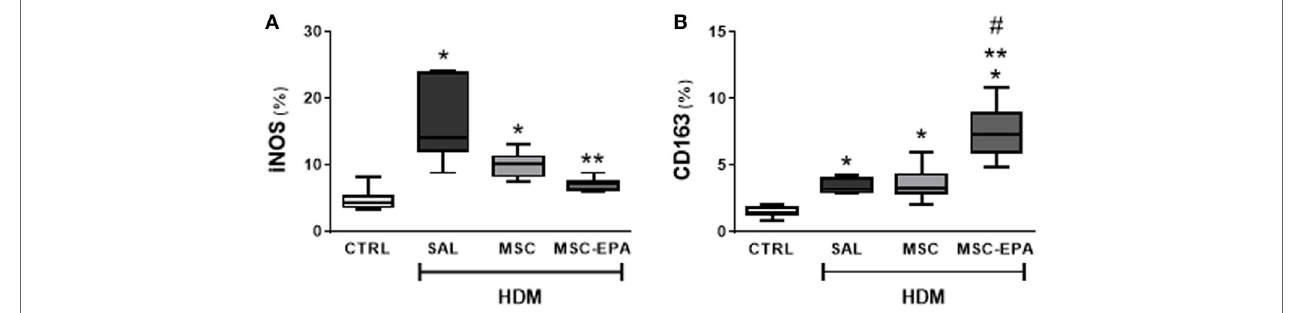
FigUre 3 | EPA-stimulated MSCs induced macrophage polarization toward an M2 rather than M1 profile. (a) M1-macrophage (iNOS + ) and (B) M2-macrophage (CD163 + ) counts in lung tissue. CTRL, saline-challenge mice; HDM, HDM-challenged mice; SAL, HDM mice treated with saline; MSC, HDM mice treated with unstimulated MSCs; MSC-EPA, HDM mice treated with EPA-stimulated MSCs. The Kruskal–Wallis test followed by Dunn’s test was used for statistical comparison. Boxes show the interquartile (25–75%) range, whiskers denote the range (minimum–maximum), and horizontal lines represent the median of eight animals/group. *Significantly different from CTRL ( p < 0.05). **Significantly different from HDM-SAL ( p < 0.05). # Significantly different from HDM-MSC ( p < 0.05). Abbreviations: EPA, eicosapentaenoic acid; HDM, house dust mite; MSCs, mesenchymal stromal